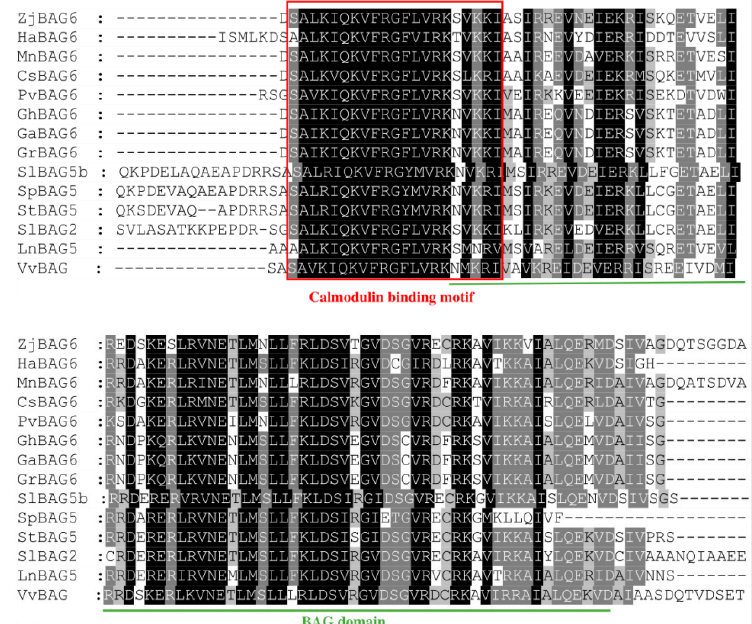
Figure 3. Alignment of SlBAG2 and SlBAG5b amino acid sequences with those of 12 other species: Solanum tuberosum (StBAG5; LOC107061352), Solanum pennellii (SpBAG5; LOC107001644), Ipomoea nil (LnBAG5; LOC109168976), Morus notabilis (MnBAG6; LOC21400474), Ziziphus jujuba (ZjBAG6; LOC107417637), Pistacia vera (PvBAG6; LOC116131206), Cannabis sativa (CsBAG6; LOC115714697), Gossypium raimondii (GrBAG6; LOC105794789), Vitis vinifera (VvBAG; LOC100260747), Gossypium hirsutum (GhBAG6; LOC107886709), Gossypium arboretum (GaBAG6; LOC108455800), and Helianthus annuus (HaBAG6;